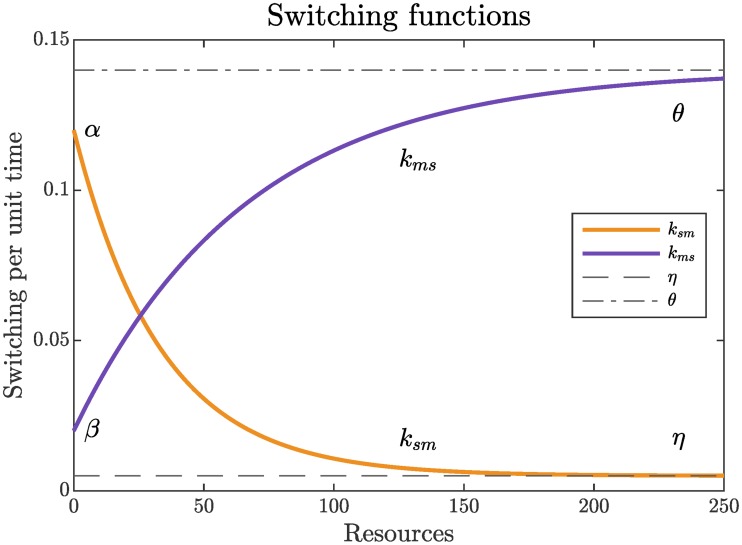
Transition rates for stationary to moving ksm (gold) and moving to stationary kms (purple) with α = 0.12, β = 0.02, γ = 0.03, δ = 0.015, η = 0.005, and θ = 0.14.